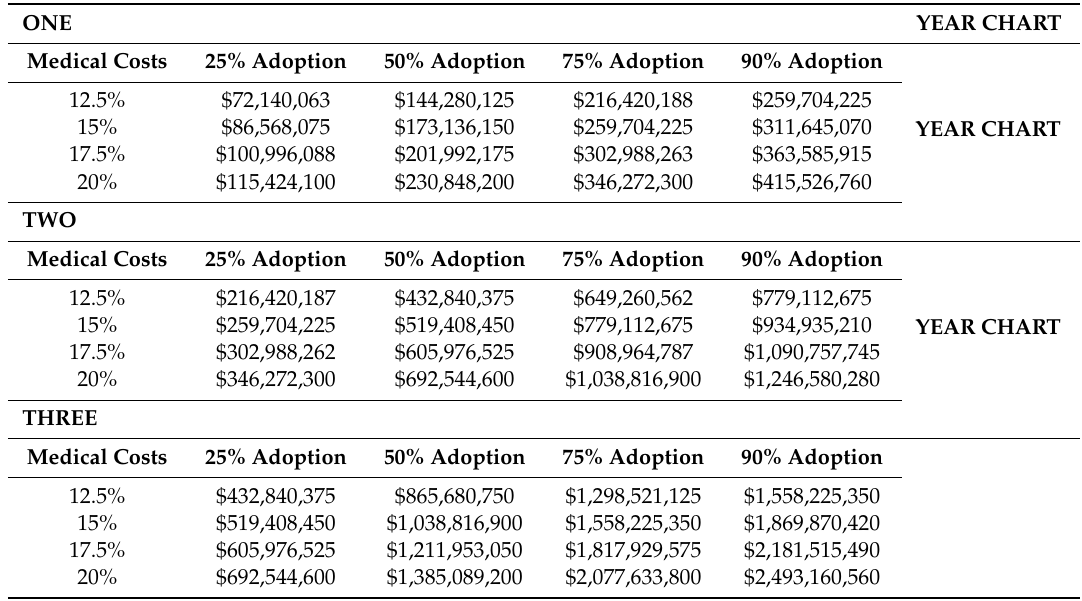
Table 3. Estimated three-year hemodialysis cost impact analysis after adoption of autonomous vehicles. ONE YEAR CHART Medical